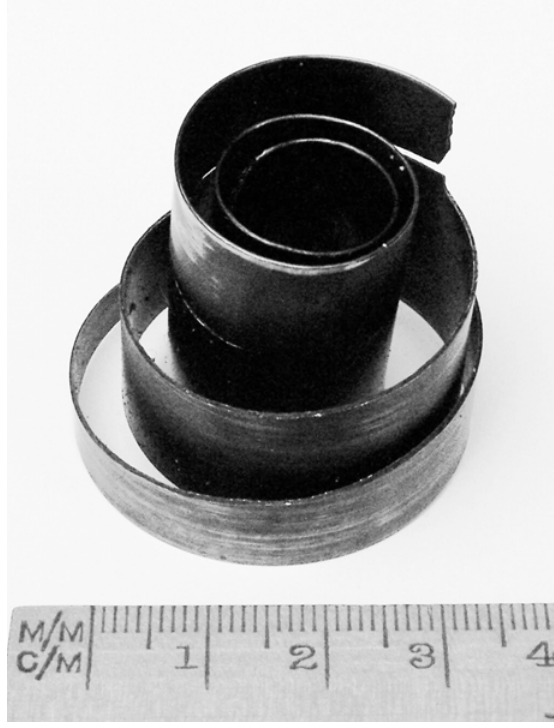
Figure 11. Centre portion of failed wall clock